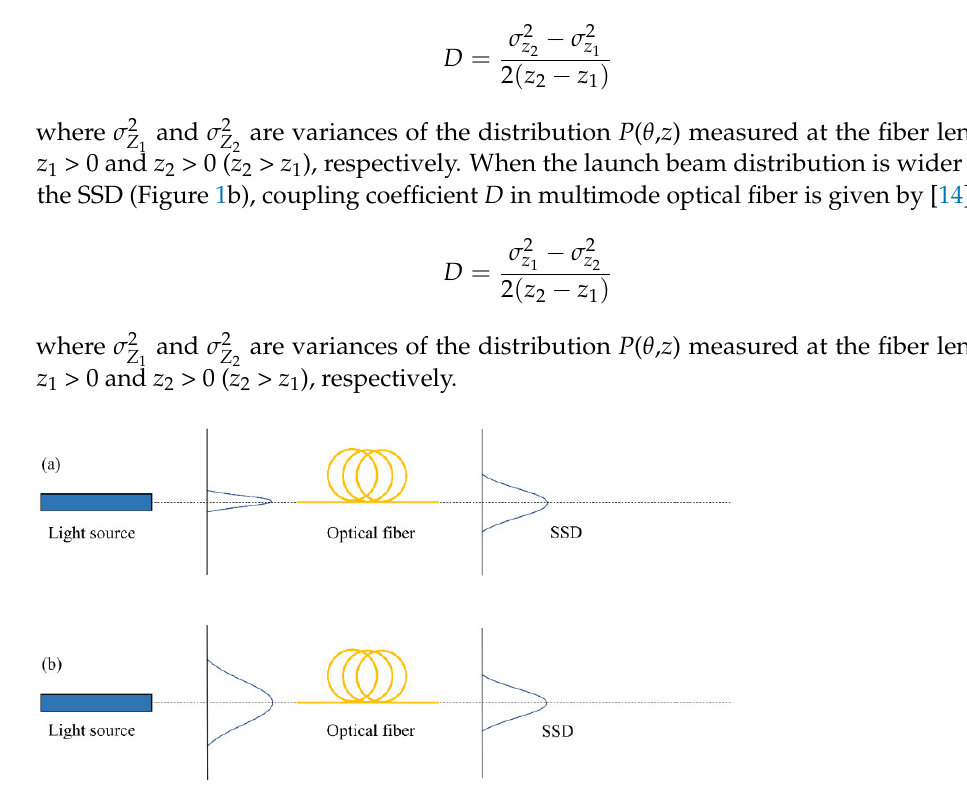
Figure 1. Sketch of the light beam centrally launched into optical fiber, where: ( a ) the input beam is narrower than the SSD; and ( b ) the input beam is wider than the SSD.